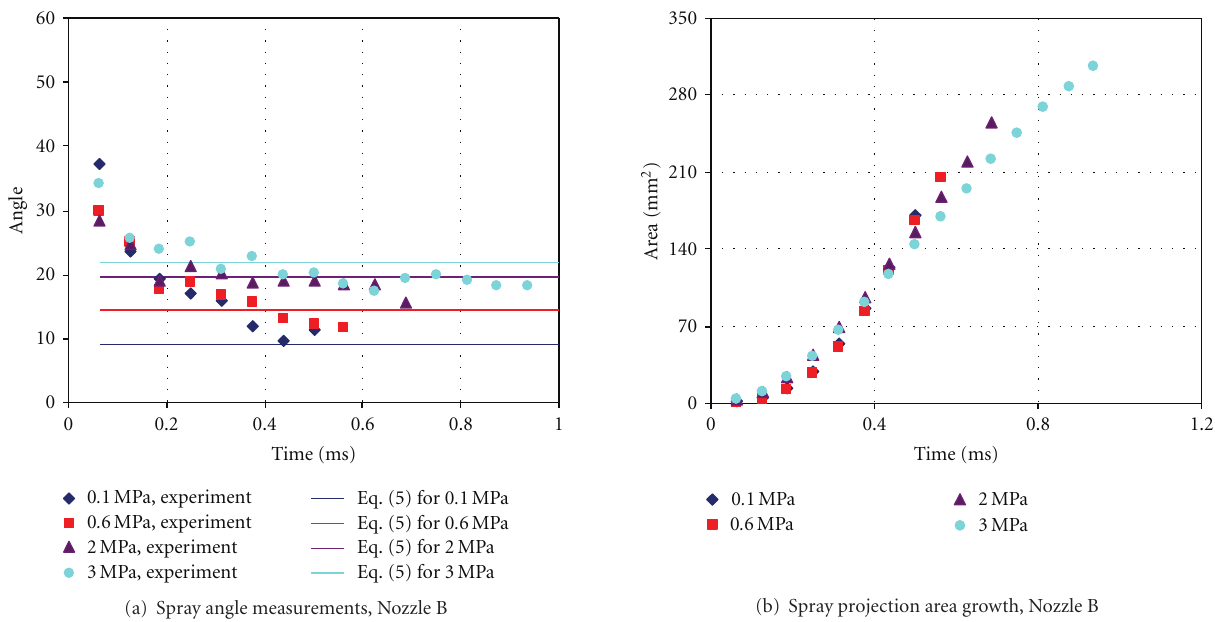
Figure 18: E ff ect of ambient pressure, Nozzle B measurements, (a) variation of spray angle by ambient pressure, (b) Variation of pressure spray projection area by ambient pressure (50MPa injection pressure, 1.5ms injection